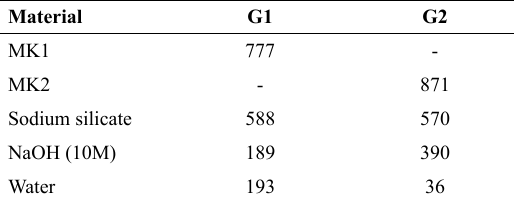
Table 6. Geopolymers compositions in kg/m 3 .